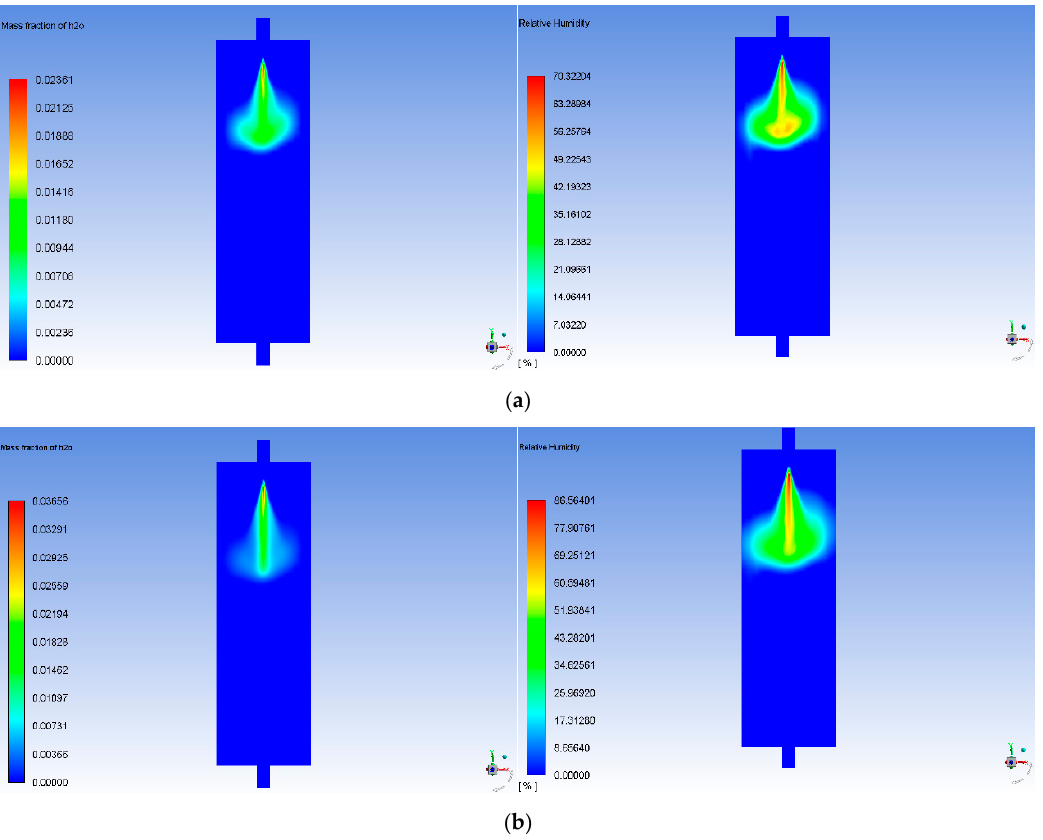
Figure 4. The relationship between water vapor mass fraction at the outlet of humidifier and air velocity.